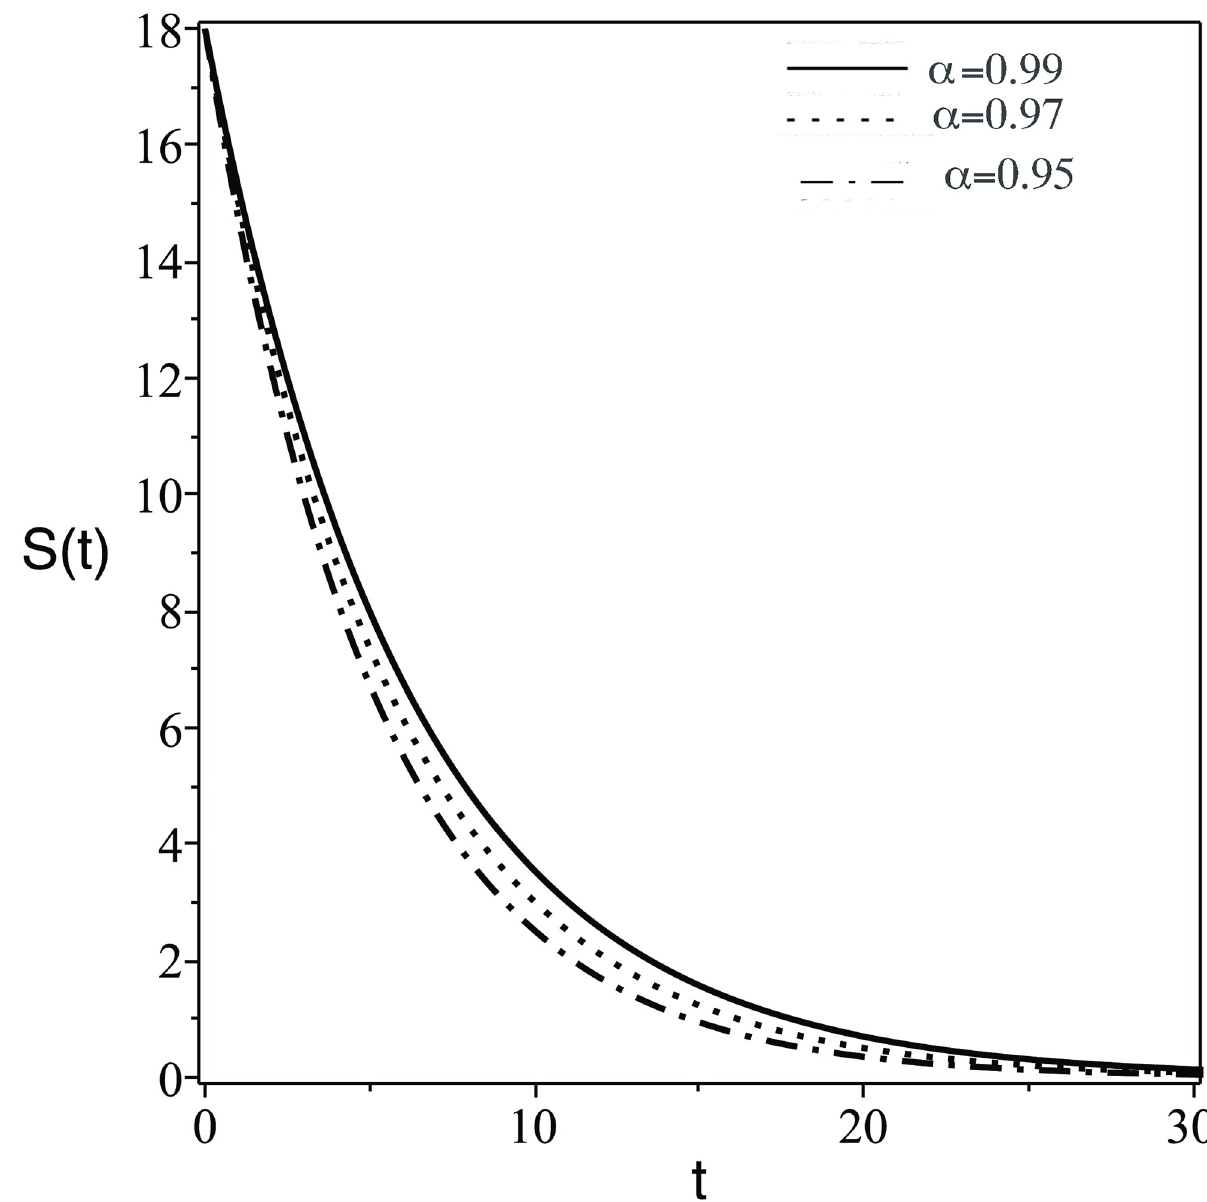
Fig 1. Number of the concentration of stem cells, S ( t ), against days (t) for different values of α .